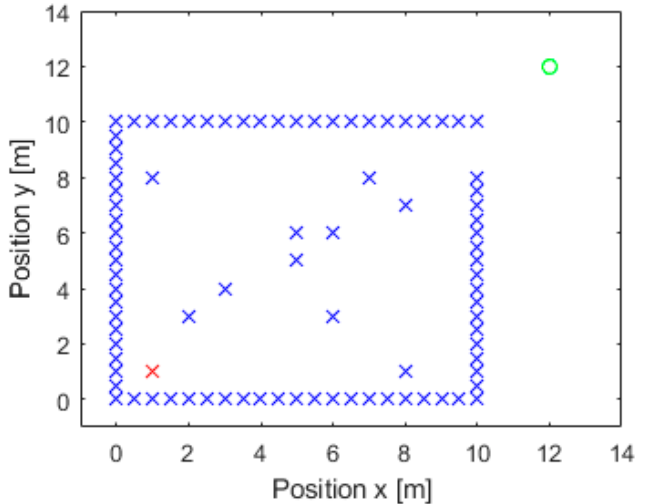
Figure 6. Proposed navigation map, including obstacles, start and end point of navigation, as well as delimited area.